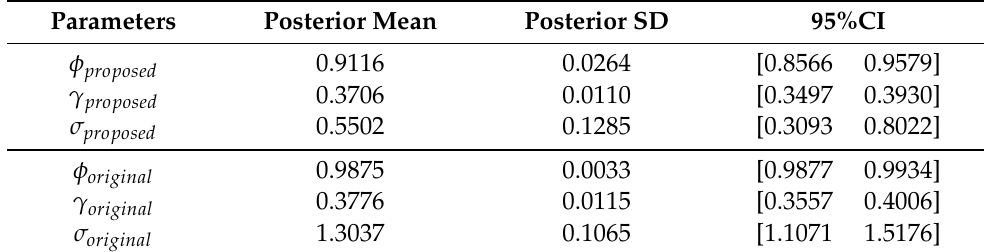
Table 35. Comparison of estimated parameters (4 January 2016, AGH, Tokyo, Japan).